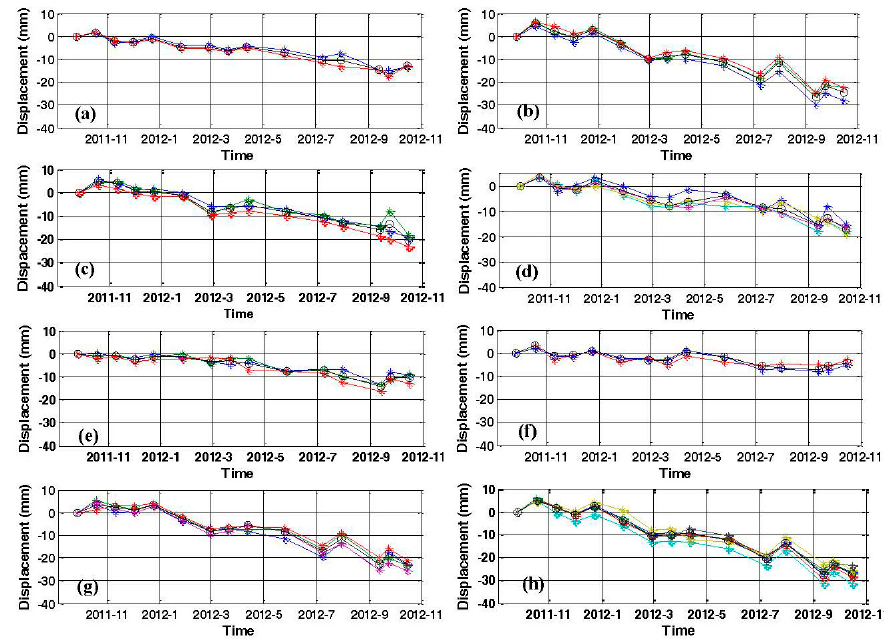
Figure 9. Time series analysis of the selected areas: Deformation of points within a 15 m radius for P1, P2, P3, P4, P6, P7, and P8 are plotted in ( a – g ). P5 is plotted separately ( h ).